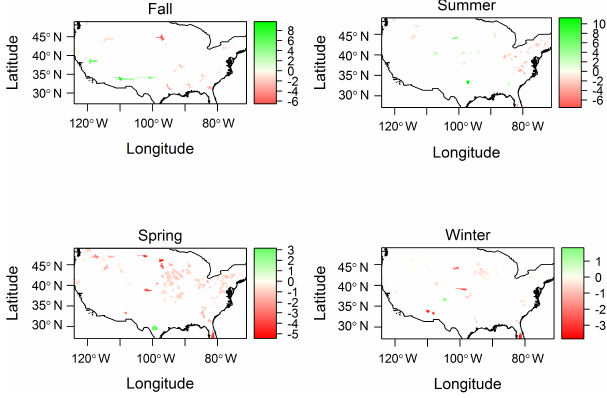
Figure 8. Seasonal distribution of streamflow elasticity due to PET (dimensionless).